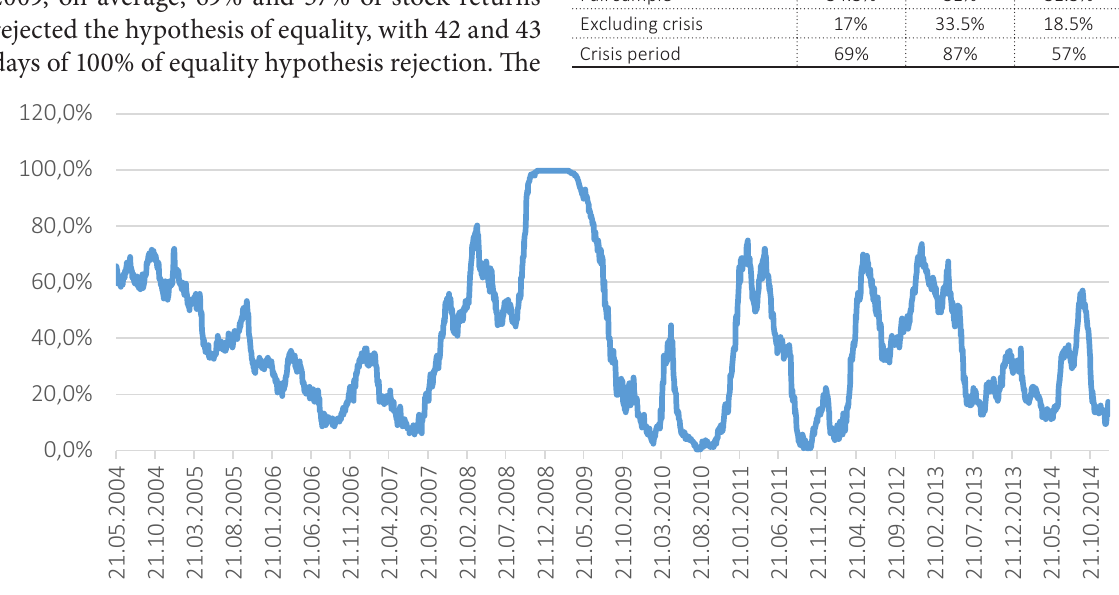
Table 2. Average rejection rate in each period Forecast sample size Period